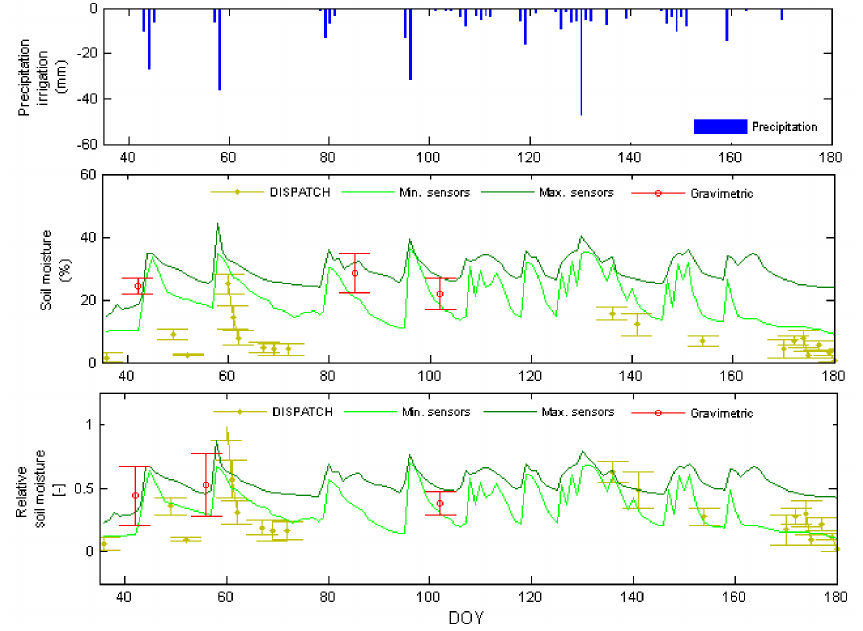
Figure 3. Comparison of average gravimetric soil moisture measurements (red) with the DISPATCH soil moisture estimations (yellow) and the daily maximum and minimum soil moisture sensor measurements (green) during the first hydrologic period (soil wet conditions caused by rainfall events